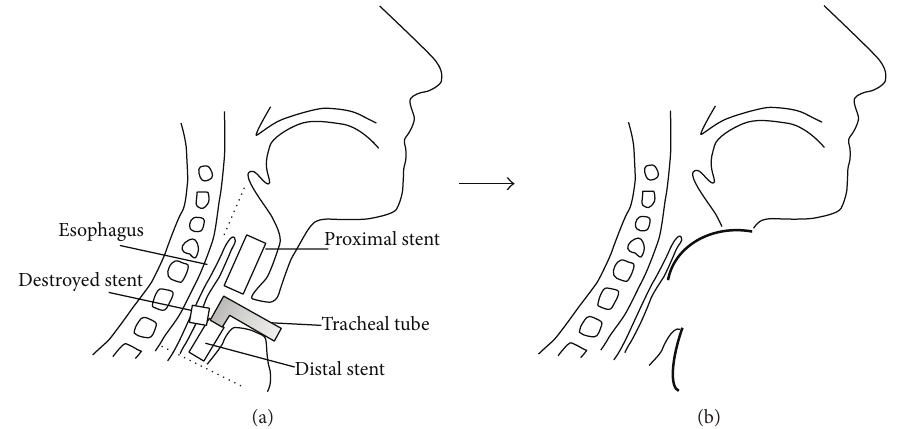
Figure 6: The schema of the tracheal excision range is represented by the dotted line on the left diagram. The postoperative anatomy, after excision of the trachea and removal of the destroyed stent, is shown in the right diagram.